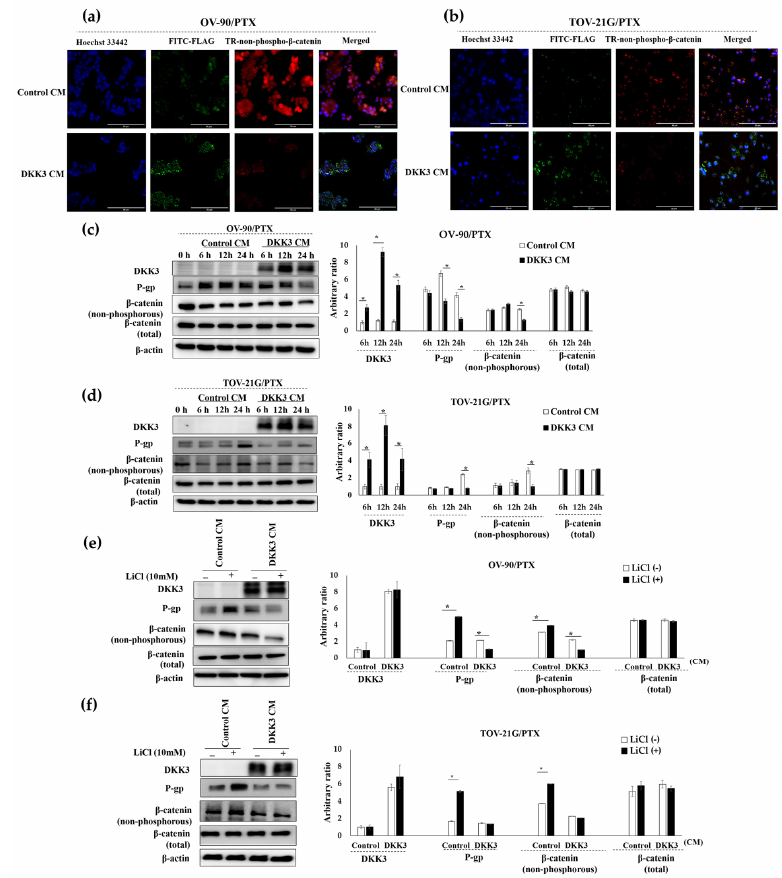
Figure 4. Secreted DKK3 enhanced paclitaxel susceptibility via inhibition of the β -catenin-P-glyco- protein signaling pathway. ( a,b ) The cells were incubated with control and DKK3 CM. Immunoflu- orescence analysis after 24 h showed that FLAG-DKK3 was present in the perinuclear area, attenu- ating TR-non-phospho- β -catenin signaling. Scale bar, 50 μ m. ( c,d ) The cells were incubated with control and DKK3 CM and subjected to Western blotting. The graphs were plotted based on the band densities (* p < 0.01). ( e,f ) To activate endogenous β -catenin, cells were treated with LiCl for 24 h and subjected to Western blot analysis. β -Actin was used as the loading control. The intensities of the Western blot bands were normalized to that of β -actin for comparison (* p < 0.01).